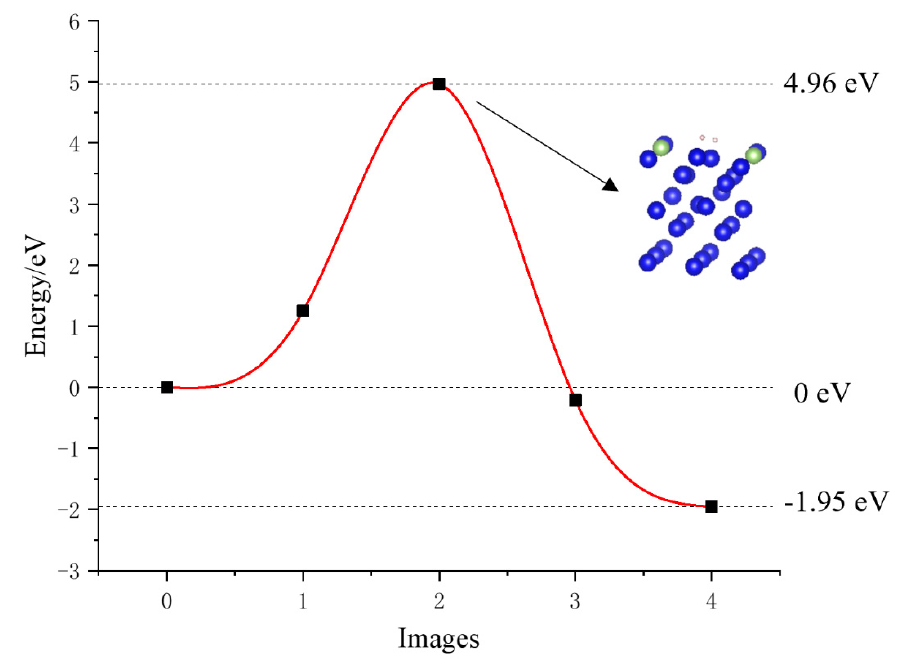
Figure 9. Minimum energy pathway for hydrogen dissociation.